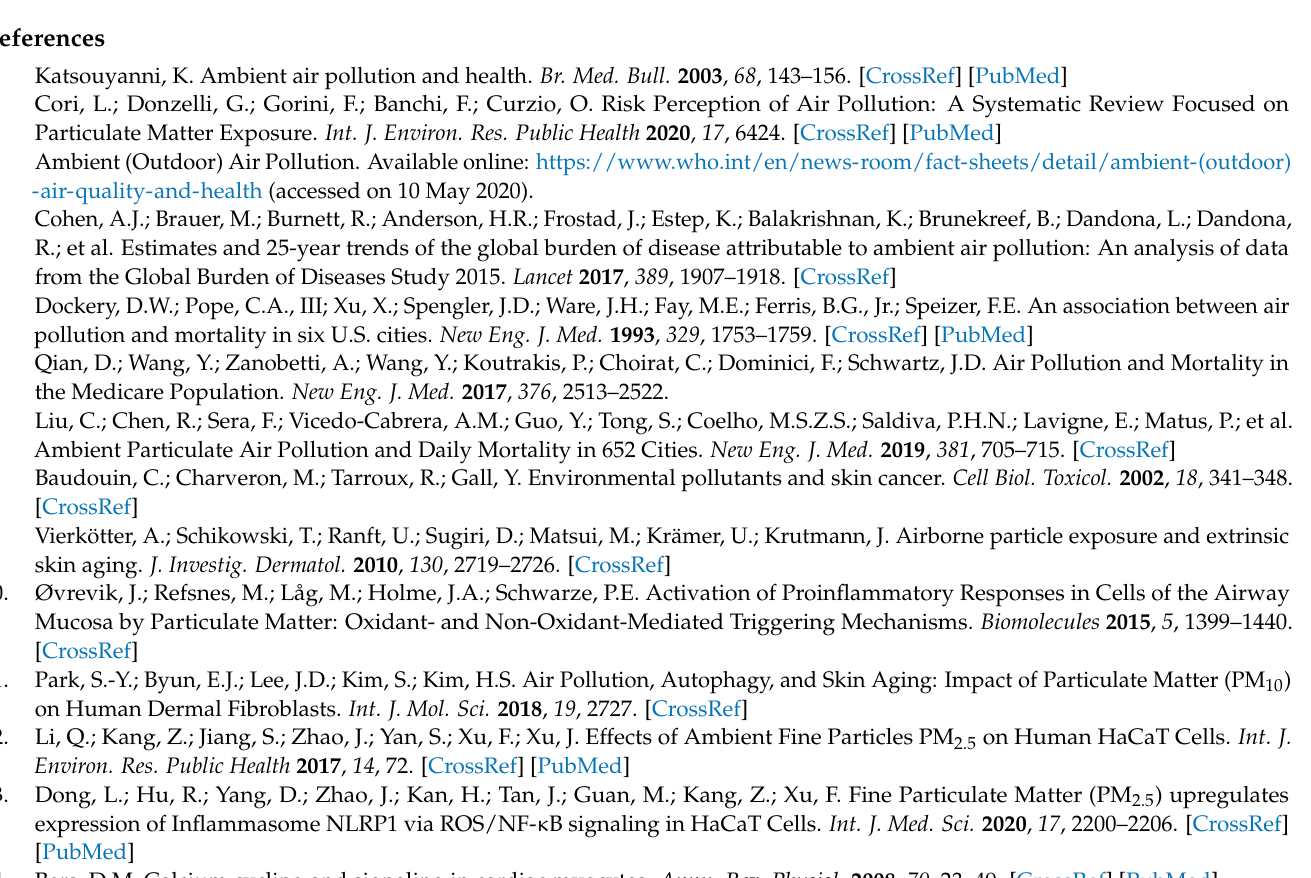
Occludin. Figure S4: Western blot of ZO-1. Figure S5: NMR spectra analyses of isolated compounds from PAE. Figure S6: Dose-dependent effect of FQA on DPM stress. Figure S7: Transcriptional regulation of PAR-2 expression by